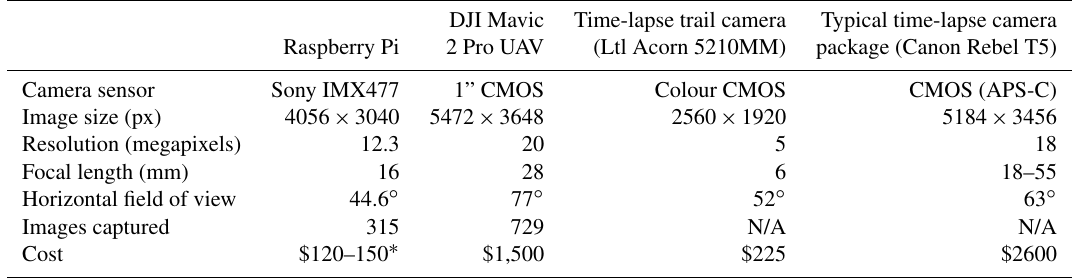
Table 1. Comparison of technical specifications between Raspberry Pi and UAV sensors. Two typical time-lapse packages are provided as a comparison, following the setup from Mallalieu et al. (2017), using the MMS model of their wildlife camera to compare like-for-like connectivity with the Raspberry Pi, and Kienholz et al. (2019). The Raspberry Pi high quality camera module is fitted with a 16mm telephoto lens. N/A stands for not